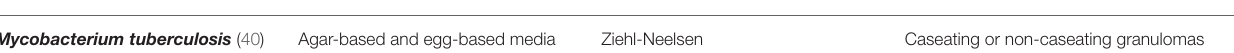
TABLE 2 | Main infectious etiologies for refractory monoarthritis: What do you find?